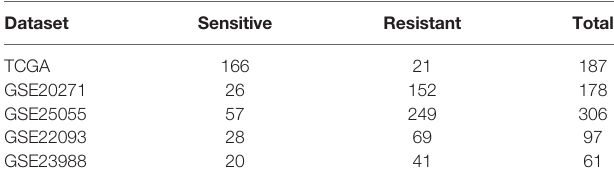
TABLE 3 | Distribution about validation data sample.